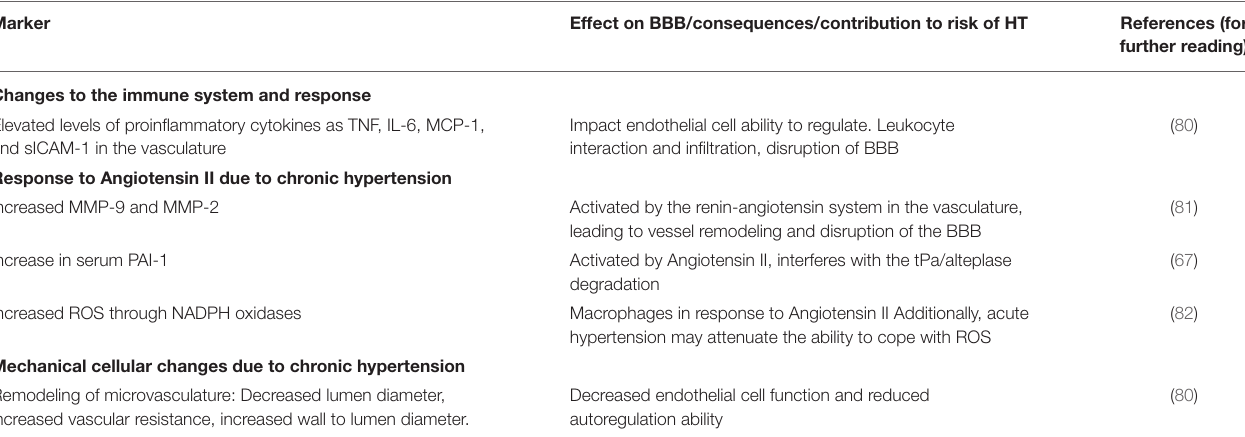
TABLE 6 | Summary of factors related to hypertension that promote BBB disruption and risk of HT.